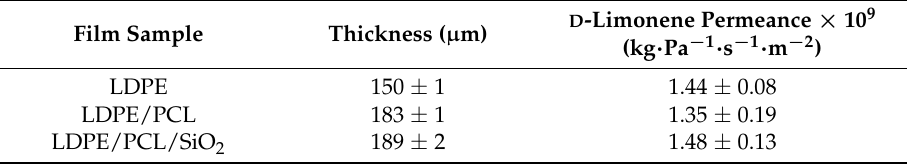
Table 5. Mean thicknesses and D -limonene permeances of the films based on low-density polyethylene (LDPE), poly( ε -caprolactone) (PCL) fibers, and silica (SiO 2 ) microparticles. PCL and SiO 2 layers were electrospun for 120 min and electrosprayed for 60 min, respectively. Values are reported as means ± standard